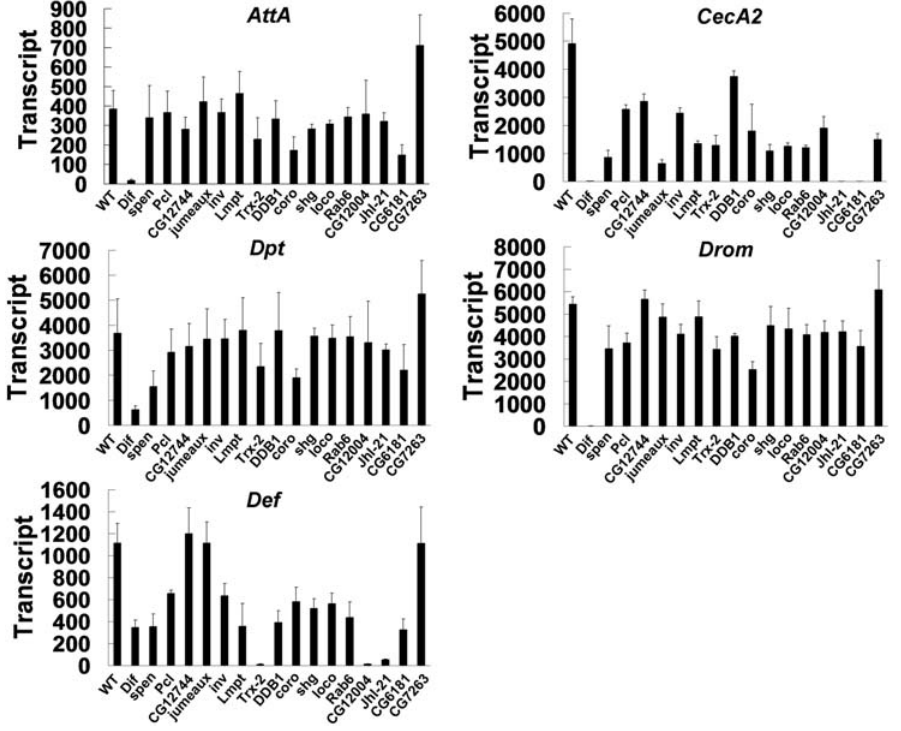
Figure 4. Expression profiles of antimicrobial peptide genes in wild type and mutant flies. Quantitative real time PCR analysis of antimicrobial peptide genes is presented. Wild type and mutant adult flies were infected with live spores of B. bassiana , total RNA was isolated from adult flies, and subjected to real time PCR analysis six hours after injection. The amount of transcripts in each sample were normalized to RpL32 transcripts (AMP transcripts=normalized target mRNA expression in sample 6 1000). The mean and standard deviation of three independent experiments are shown. AttA , Attacin A ; CecA2 , Cecropin A2 ; Drom , Drosomycin ; Dpt , Diptericin ; Def , Defensin .